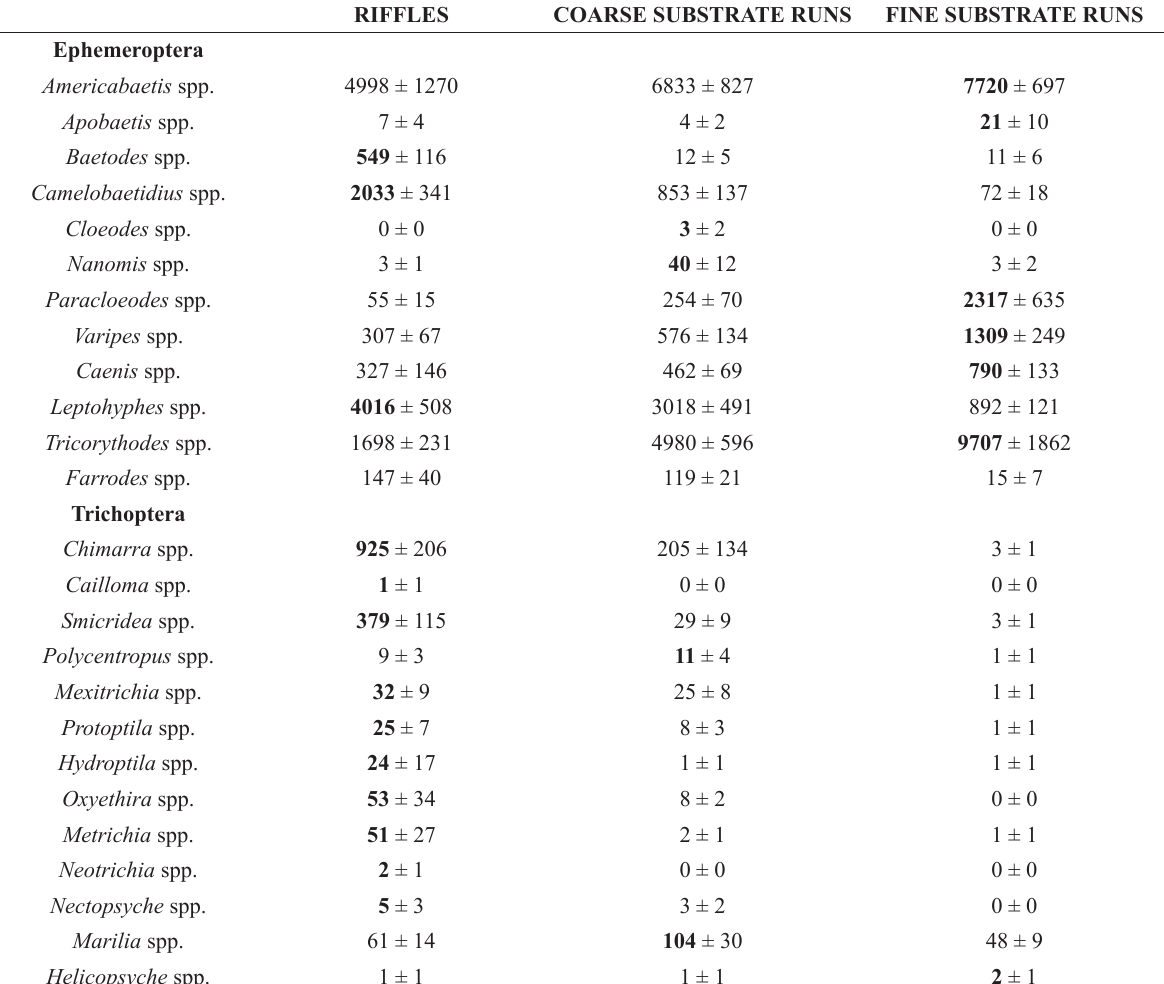
streams. The highest mean values of abundance are in